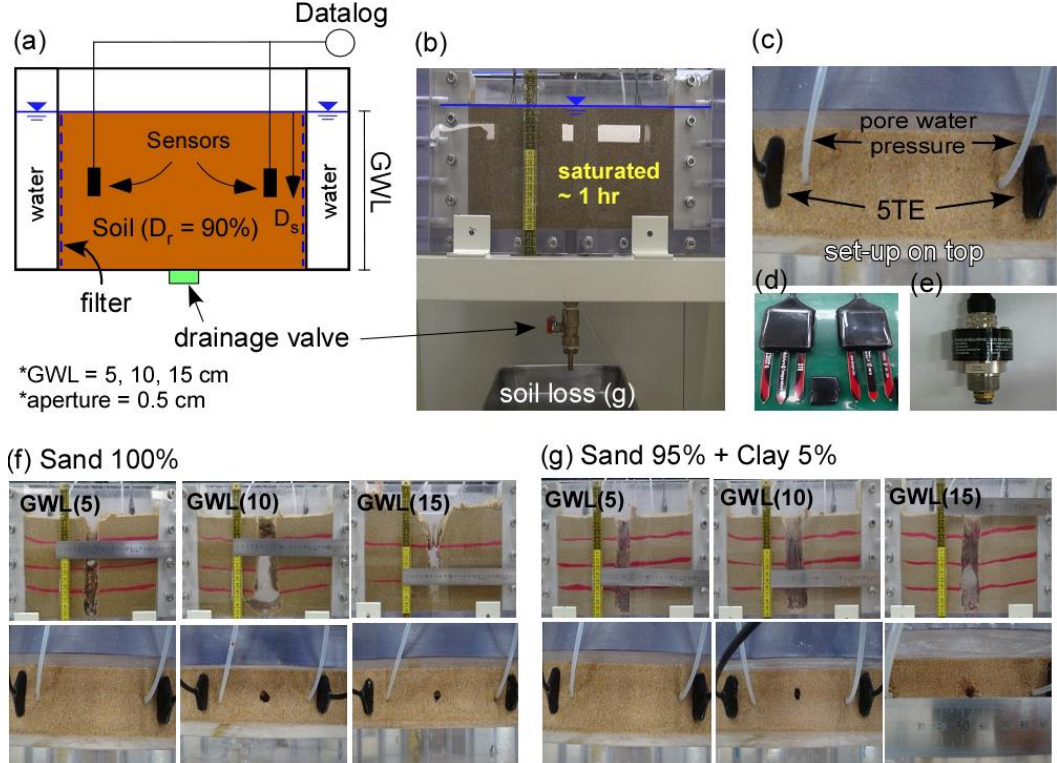
Figure 1. Tank model apparatus: ( a ) model diagram with sensors; ( b ) saturation; ( c ) setup; ( d ) sensor (called 5TE) designed to measure electrical conductivity, temperature and water content; ( e ) pore water pressure sensor; ( f ) sand; ( g ) sand-clay mixture. Figure 1f,g show significant punching failure type for water levels of 10 and 15 cm high.